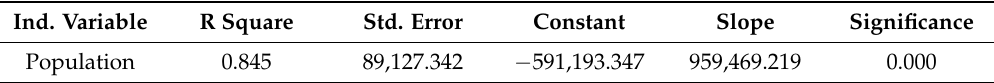
Table 1. Summary of the model with Population as the variable.